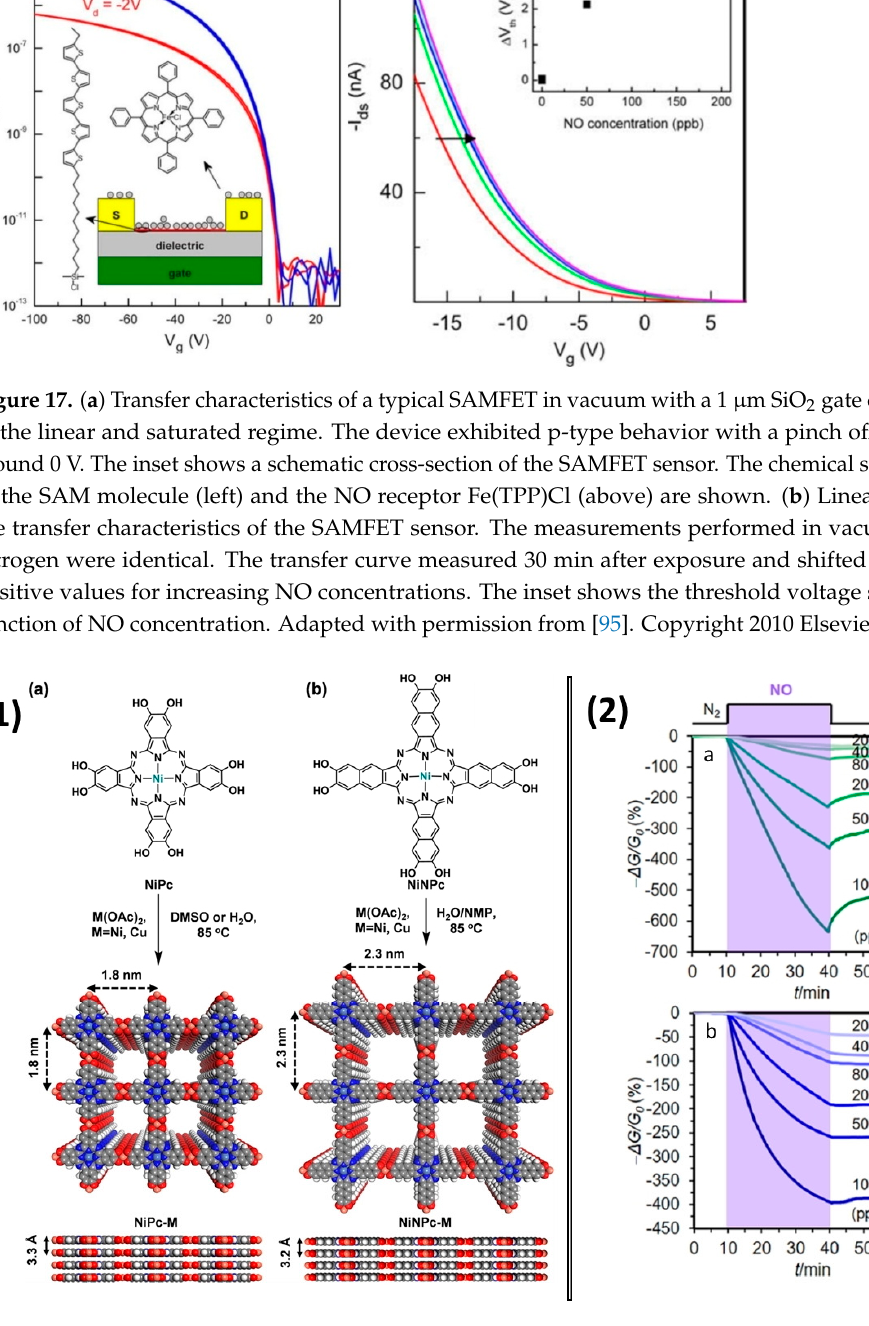
Figure 18. ( 1 ) Synthetic scheme for isoreticular phthalocyanine and naphthalocyanine-based MOFs ( a ) NiPc-M and ( b ) NiNPc-M. Top and side view of their structures with 2 × 2 square grids in eclipsed stacking mode. ( 2 ) Response of NiPc-Ni MOF ( a ) and NiPc-Cu MOF ( b ) to NO at different concentrations. Reprinted with permission from [96] Copyright 2019 American Chemical Society.